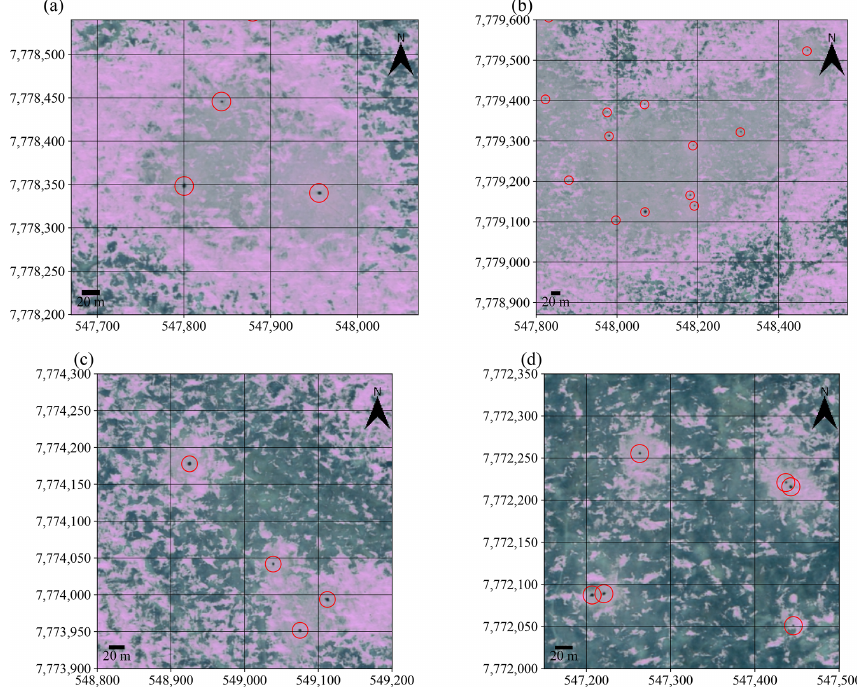
Figure 12. Examples of patterns around holes in a true-colour composite of the WorldView-2 image acquired on 22 May 2016. Red circles indicate locations of detected holes as identified by the blob-detection algorithm. CRS: WGS 84 / UTM zone 42N.